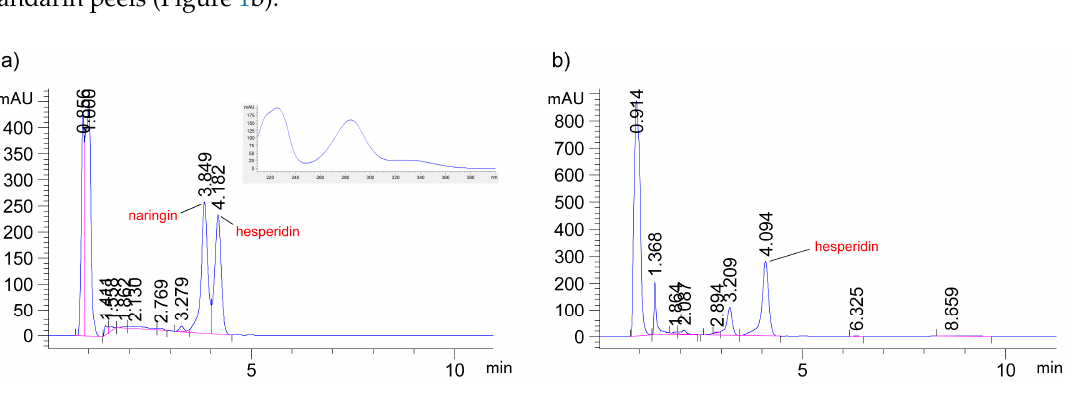
Figure 1. High performance liquid chromatography (HPLC)-DAD chromatograms for hesperidin analysis: ( a ) HPLC chromatogram of naringin and hesperidin standards (inset: UV spectrum of hesperidin standard); ( b ) HPLC chromatogram of hesperidin in mandarin peel